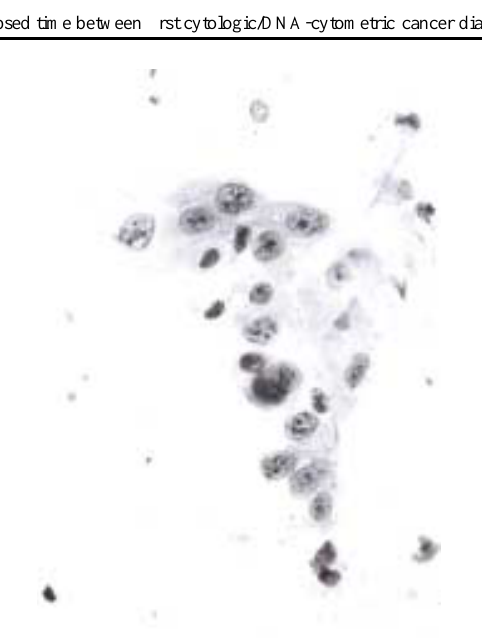
Fig. 4. Atypical oral musoca cells, suspicious for squamous cell car- cinoma with enlarged and slightly polymorphic nuclei containing prominent nucleoli and coarse chromatin. Patient B. Primary magni- fication 630 × .